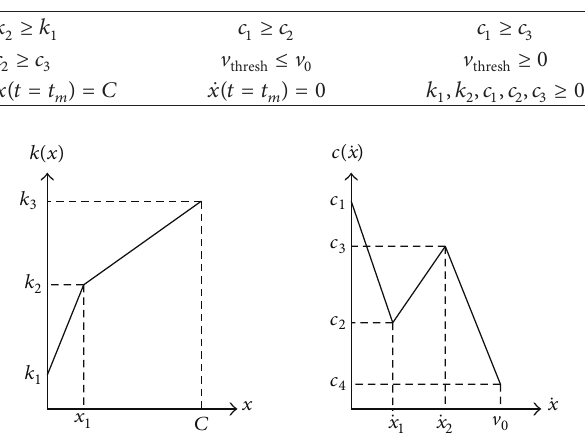
Table 1: Side-constraints.